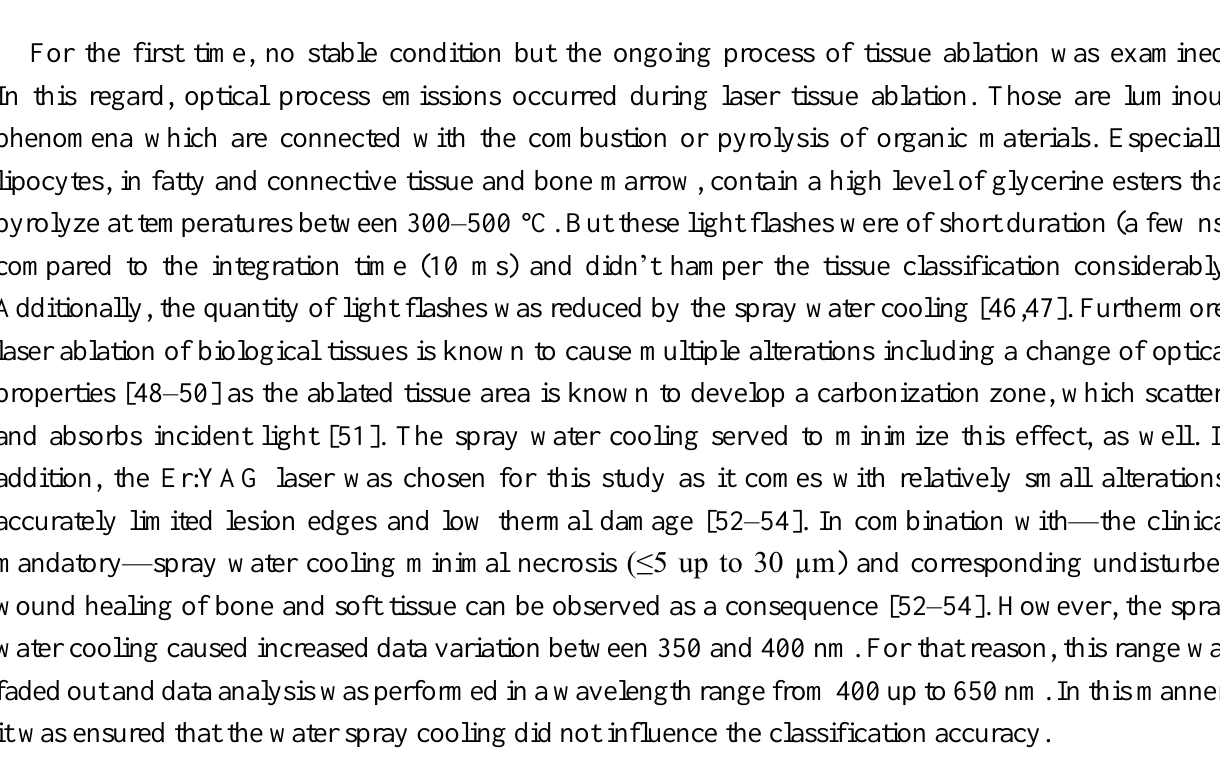
Figure 7. Nerve tissue with laser ablation crater after 20